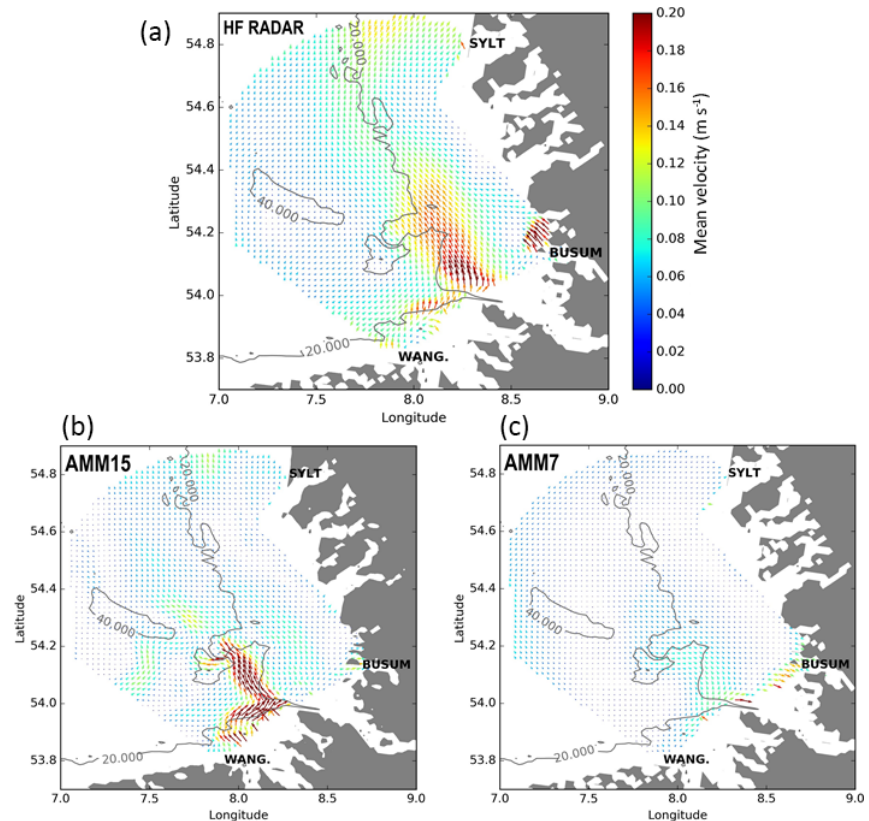
Figure 8. March 2017 average surface flow for HF radar (a) , AMM7 (b) , and AMM15 (c) . Model data are regridded on the HF radar grid using cubic interpolation. The hourly model output is linearly interpolated every minute to match the HF radar observations. Model output is only plotted where HF radar data are available. Grey lines represent the 20 and 40m isobaths. SYLT, WANG, and BUSUM show the locations of the three HF radars on the islands of Sylt and Wangerooge, and in Büsum,